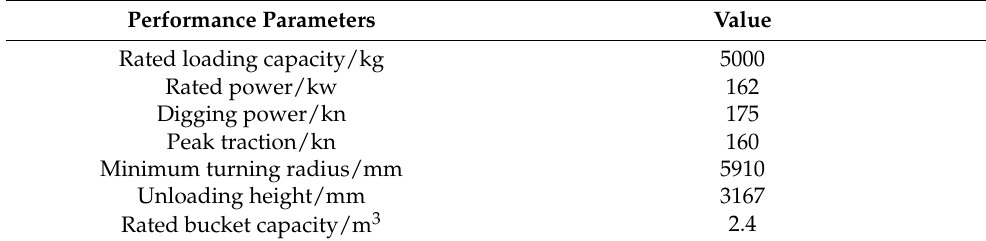
Figure 3. The three-dimensional model of the 958 N loader. Table 2. The performance parameters of the 958 N